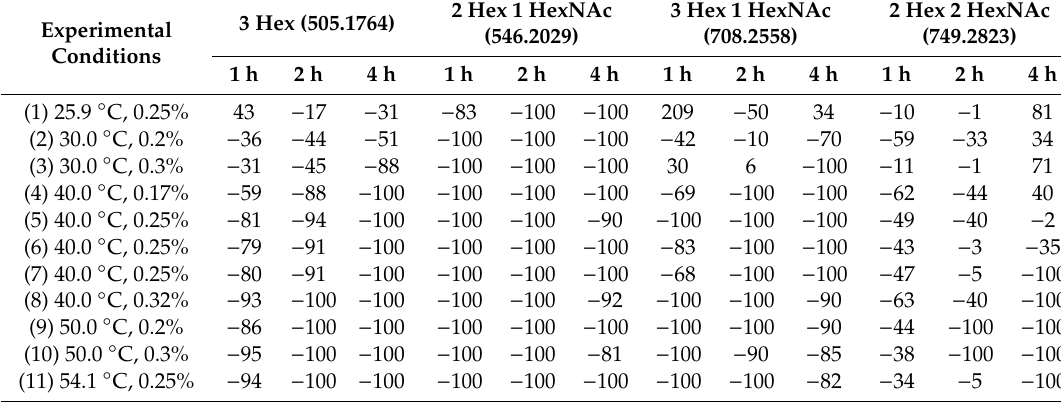
treatment for 1, 2, and 4 h from 11 experimental